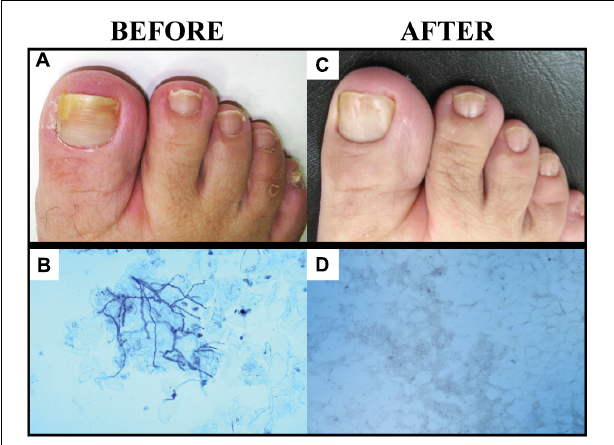
FIGURE 7 | Images showing patients with onychomycosis caused by Trichophyton spp. before and after treatment with PE. Patient with toenail onychomycosis before treatment with PE (A) ; nail scrapings cleared with KOH plus Parker’s blue–black permanent ink, observed by direct microscopy (B) ; complete resolution of the nail, fully recovered to its initial appearance (C) ; and no fungi present in the sample (D)